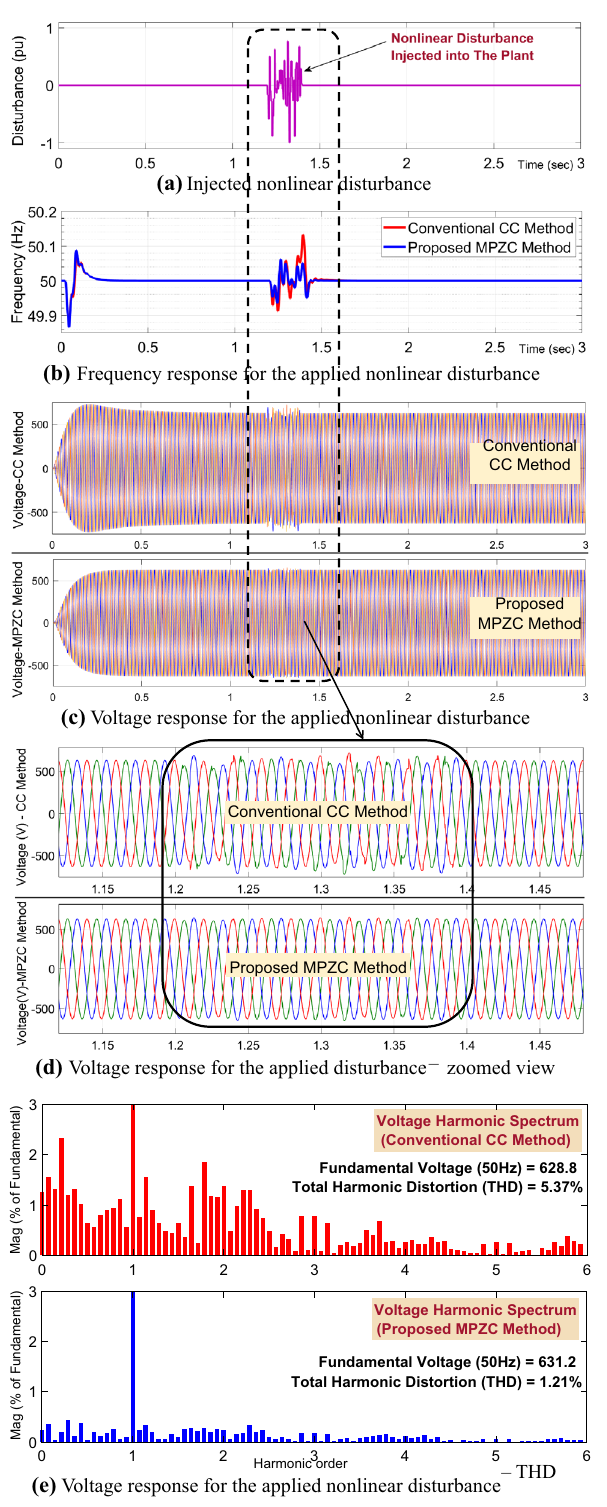
Fig. 16 Frequency and voltage responses for test case-T